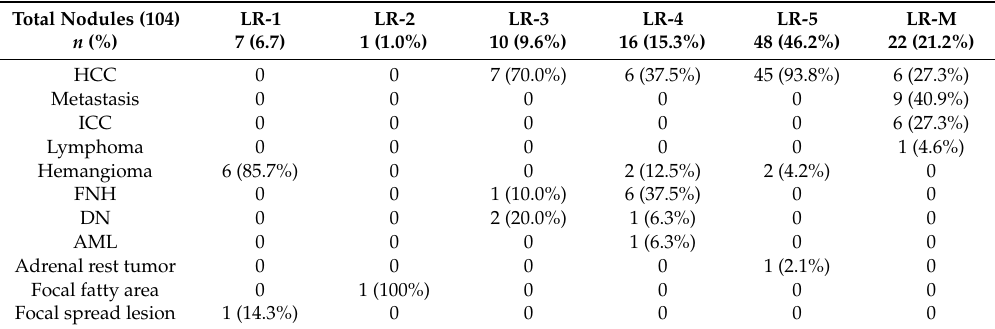
Table 4. Distribution of nodules in modified CEUS LI-RADS